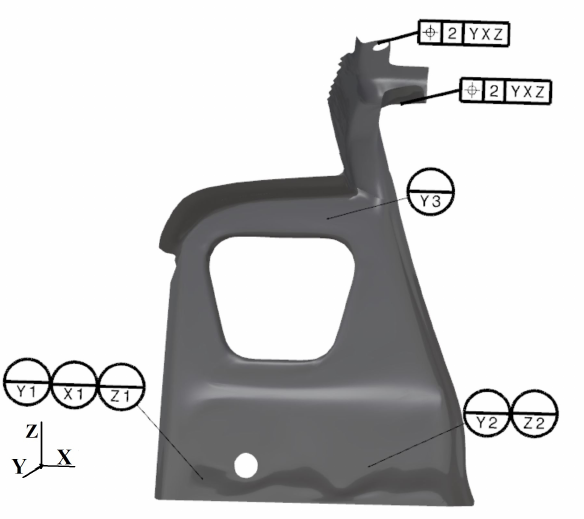
Figure 2. The utilized sample case and its KPC